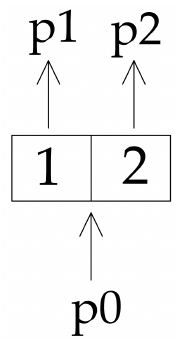
Figure 1. Two-section